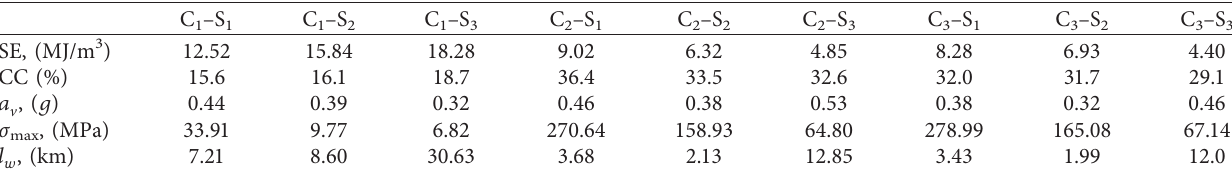
Table 2: Performance data ( g � 9.8m/s 2 ).